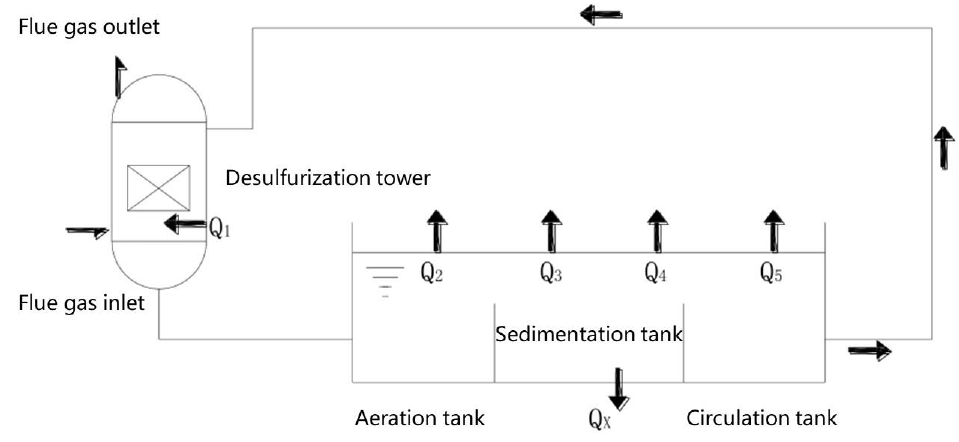
Figure 5. Flow chart of flue gas desulfurization and waste heat recovery system.